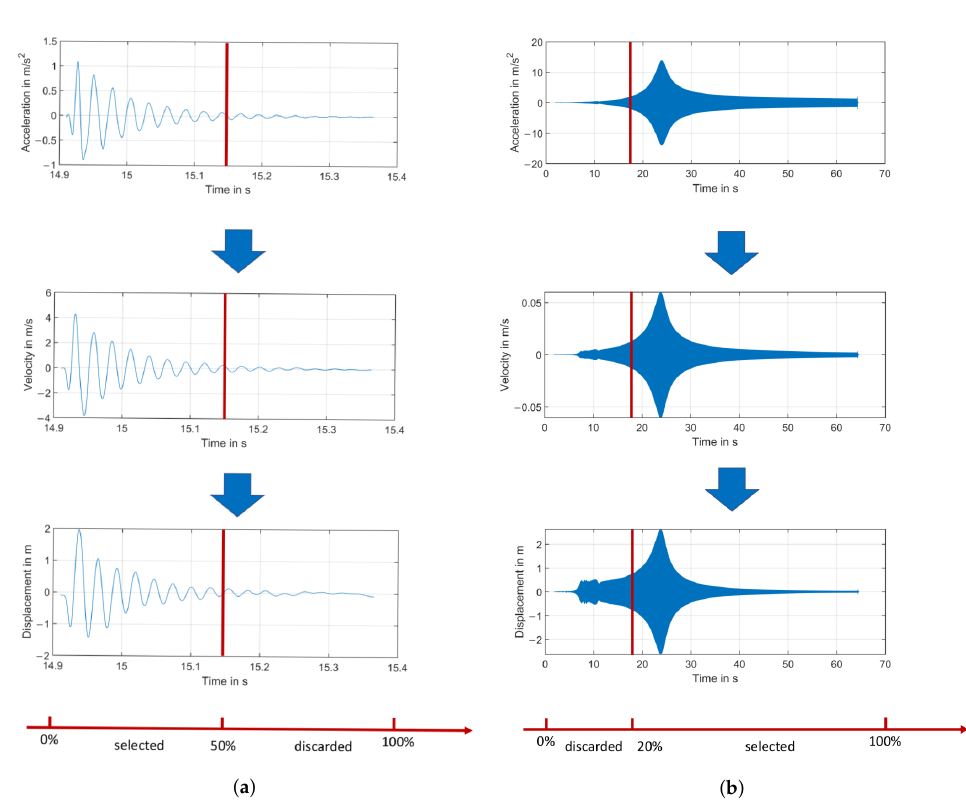
Figure 16. The selected intervals from measurement with ( a ) impulse excitation and ( b ) sweep signal excitation.